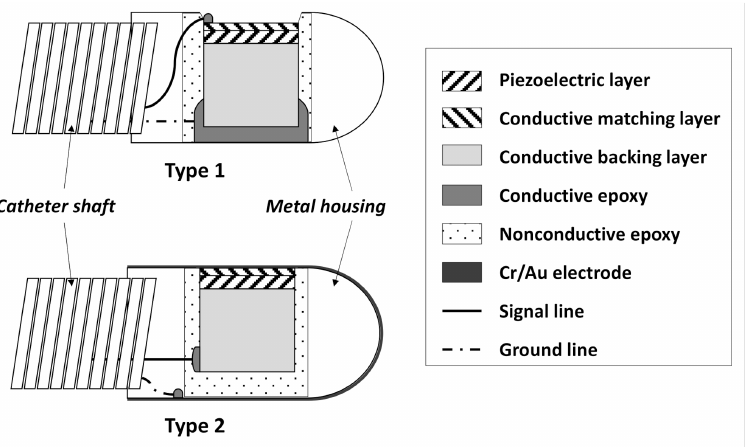
Figure 5. Structures of IVUS transducer depending on methods for signal line